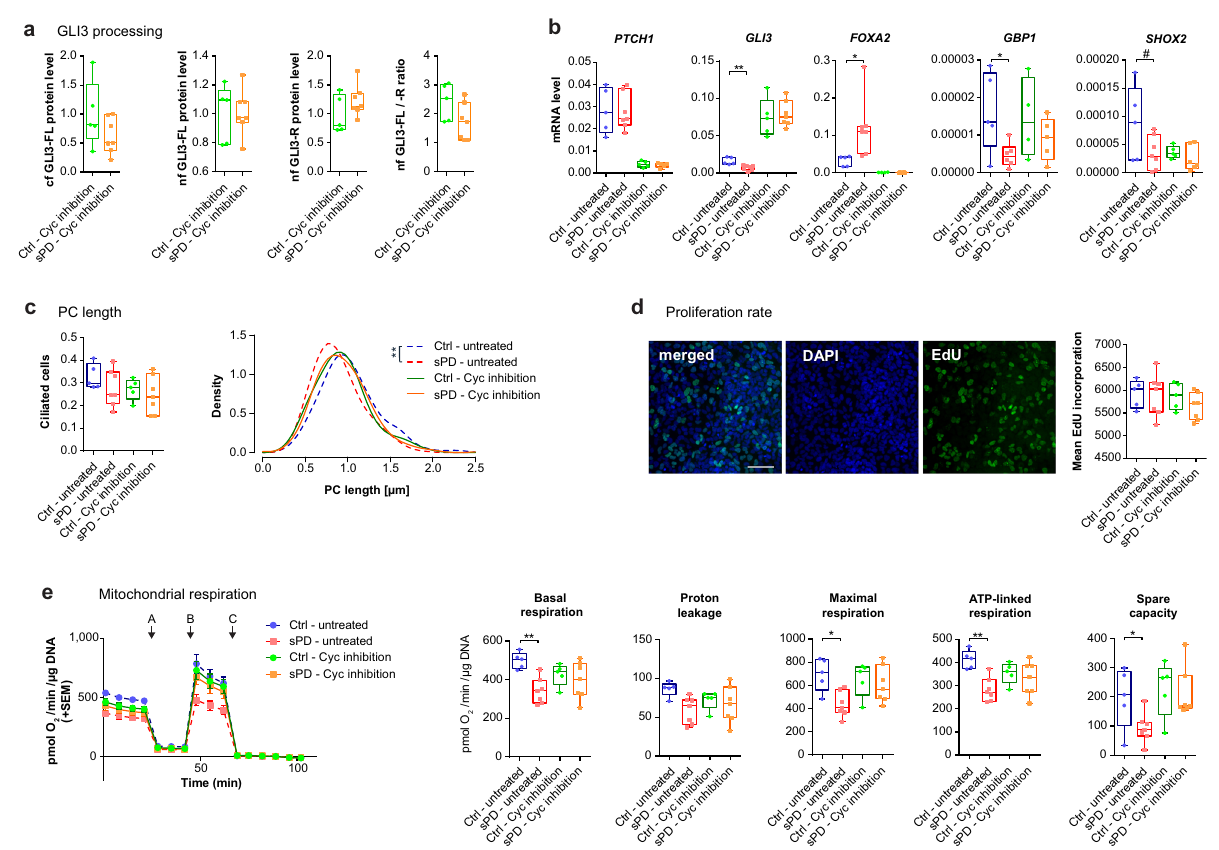
Fig. 7 | Interfering with SHH signaling rescues PD associated alterations. a Quanti fi cation of full length GLI3 (GLI3-FL) and GLI3 transcriptional repressor (GLI3-R) in the cytoplasmic (cf) or nuclear (nf) fraction of protein extracts from hNPCs upon cyclopamine (Cyc) inhibition (10 µ M for 4 days). b SHH receptor PTCH1 , transcription factor GLI3 and the signaling targets FOXA2 , GBP1 , SHOX2 analyzed on mRNA levelbyRT-qPCR in hNPCs(DMSOctrland Cyctreated − 10 µ M for4days). c (right)DensityplotillustratingthedistributionofPClength(in µ m)in ahNPCpopulation(DMSOctrlandCyctreated − 10 µ Mfor4days).(left)Fractionof ciliated cells. PC length was measured in immunostainings of hNPCs positive for anti-NES and anti-ARL13B. Analyzed were n =40 cilia per clone. d Cell proliferation rate of hNPCs (DMSO ctrl and Cyc treated − 10 µ M for 4 days) determined by EdU incorporation after 2h of EdU treatment. e Mitochondrial stress test performed in hNPC (DMSO ctrl and Cyc treated − 10 µ M for 4 days) using a Seahorse XFe96 Extracellular Flux Analyzer. Injected were (A) Oligomycin (1 µ g/ml), (B) FCCP (0.5 µ M), (C) Rotenone (5 µ M)/Antimycin A (2 µ M). Measurement progression